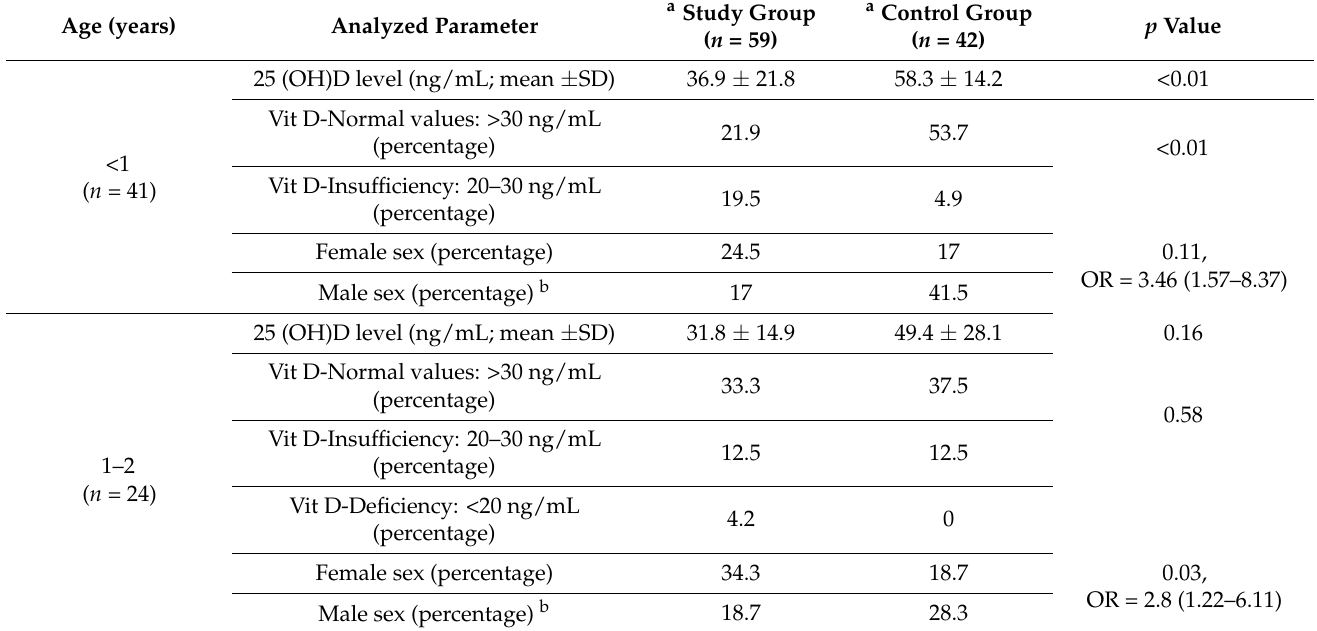
Table 3. Comparison of age groups depending on 25(OH)D levels and female/male sex